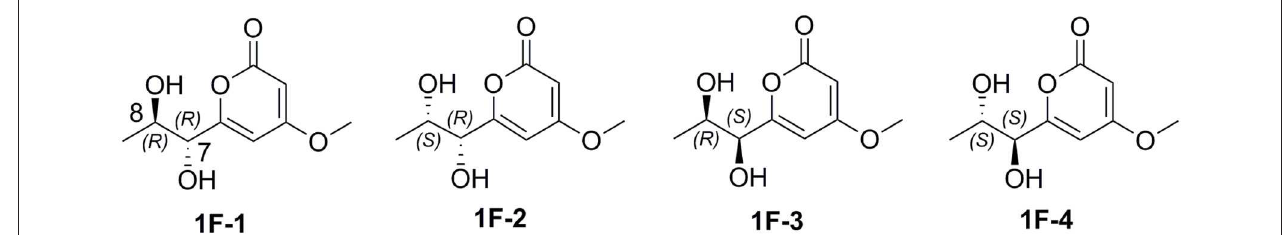
FIGURE 6 | The structures of 1F-1–1F-4 .